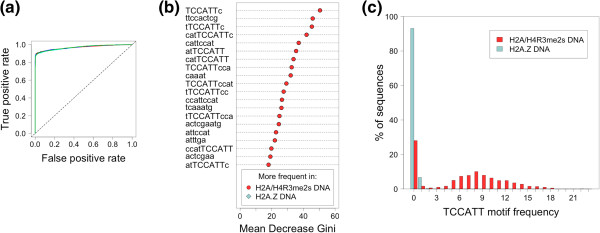
Classifying stable nucleosomes containing H2A/H4R3me2s or H2A.Z using DNA sequence features. (a) Receiver Operating Characteristic (ROC) curve, demonstrating classifier performance. (b) Random forests feature importance by mean decrease in Gini index. Features have a higher frequency in H2A/H4R3me2s nucleosomal DNA (red) or H2A.Z nucleosomal DNA (blue). (c) Frequency histogram of the number of occurrences of the motif TCCATT in H2A/H4R3me2s nucleosomal DNA (red) or H2A.Z nucleosomal DNA (blue).